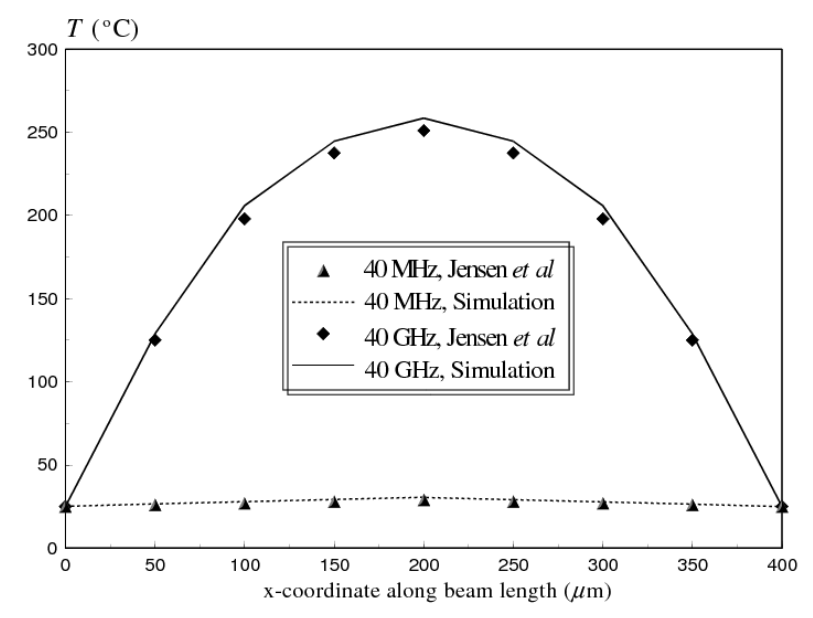
Figure 4. Substructured EM-thermal model predictions versus numerical model results reported by Jensen et al. [5] of the temperature distribution versus coordinate along beam length for fixed-fixed gold beam at frequencies of 40 MHz and 40 GHz ( l W = 50 µm , t = 2 µm m m